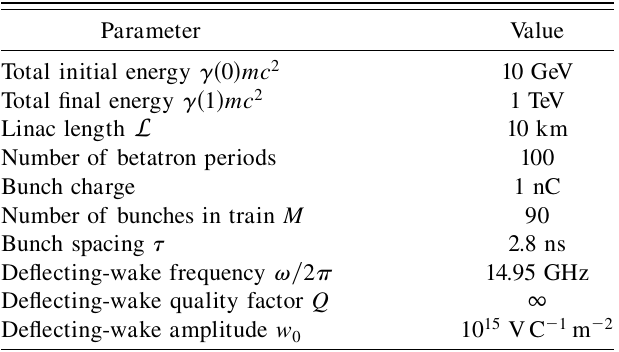
TABLE I. Nominal top-level linear-collider design parame- ters